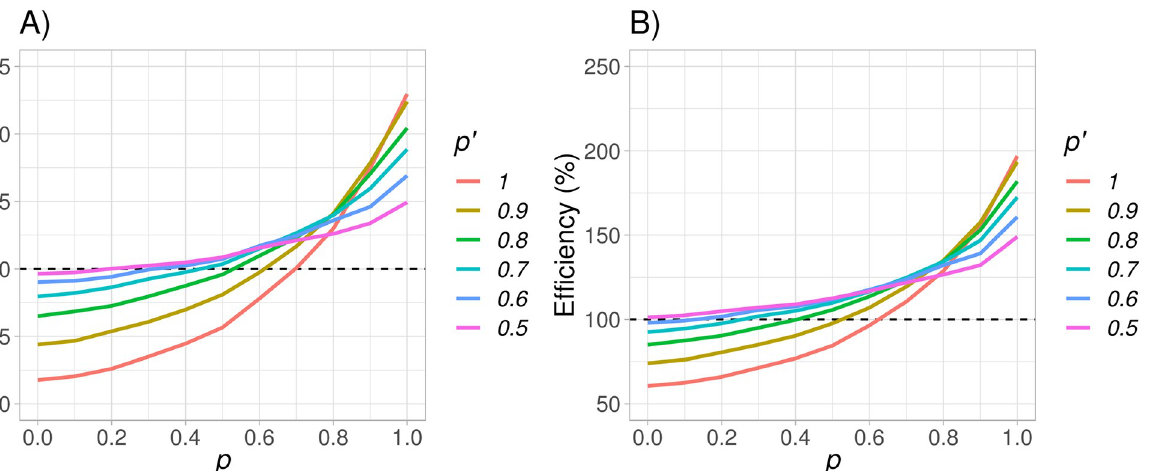
¼ 10 months varying p between 0